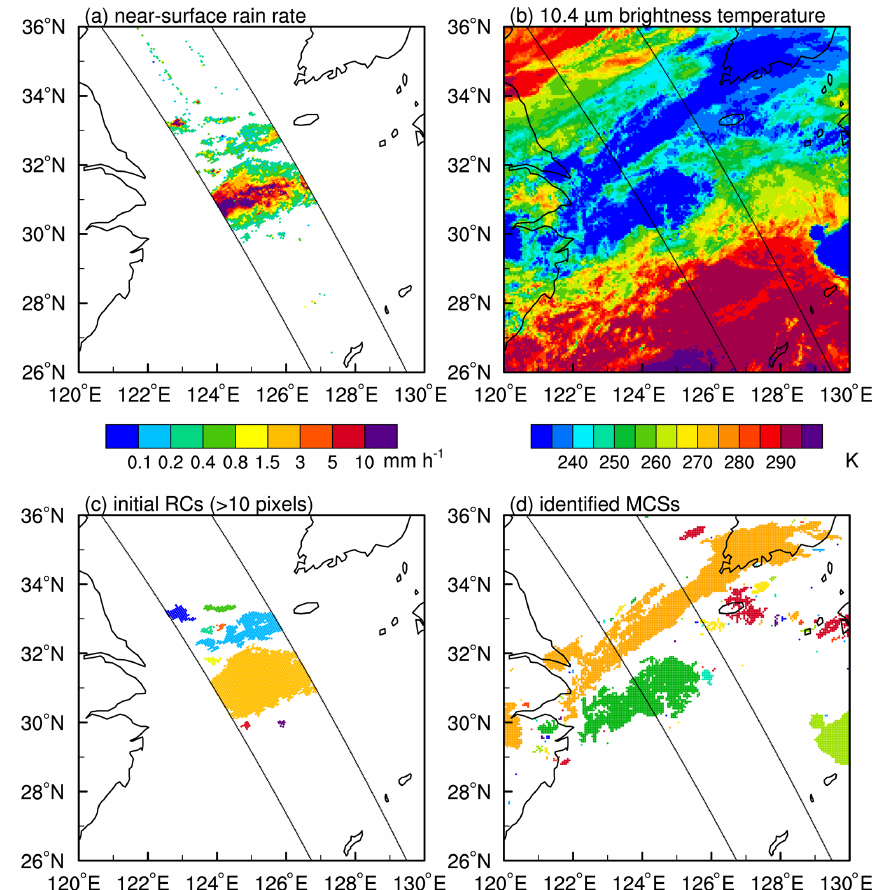
Figure 5. Horizontal distributions of the (a) near-surface rain rate, (b) 10.4µm brightness temperature, (c) initial RCs, and (d) identified MCSs for the precipitation event occurring at 23:09UTC on 2 June 2020. The adjacent dots of different colors in panels (c) and (d) indicate different RCs or